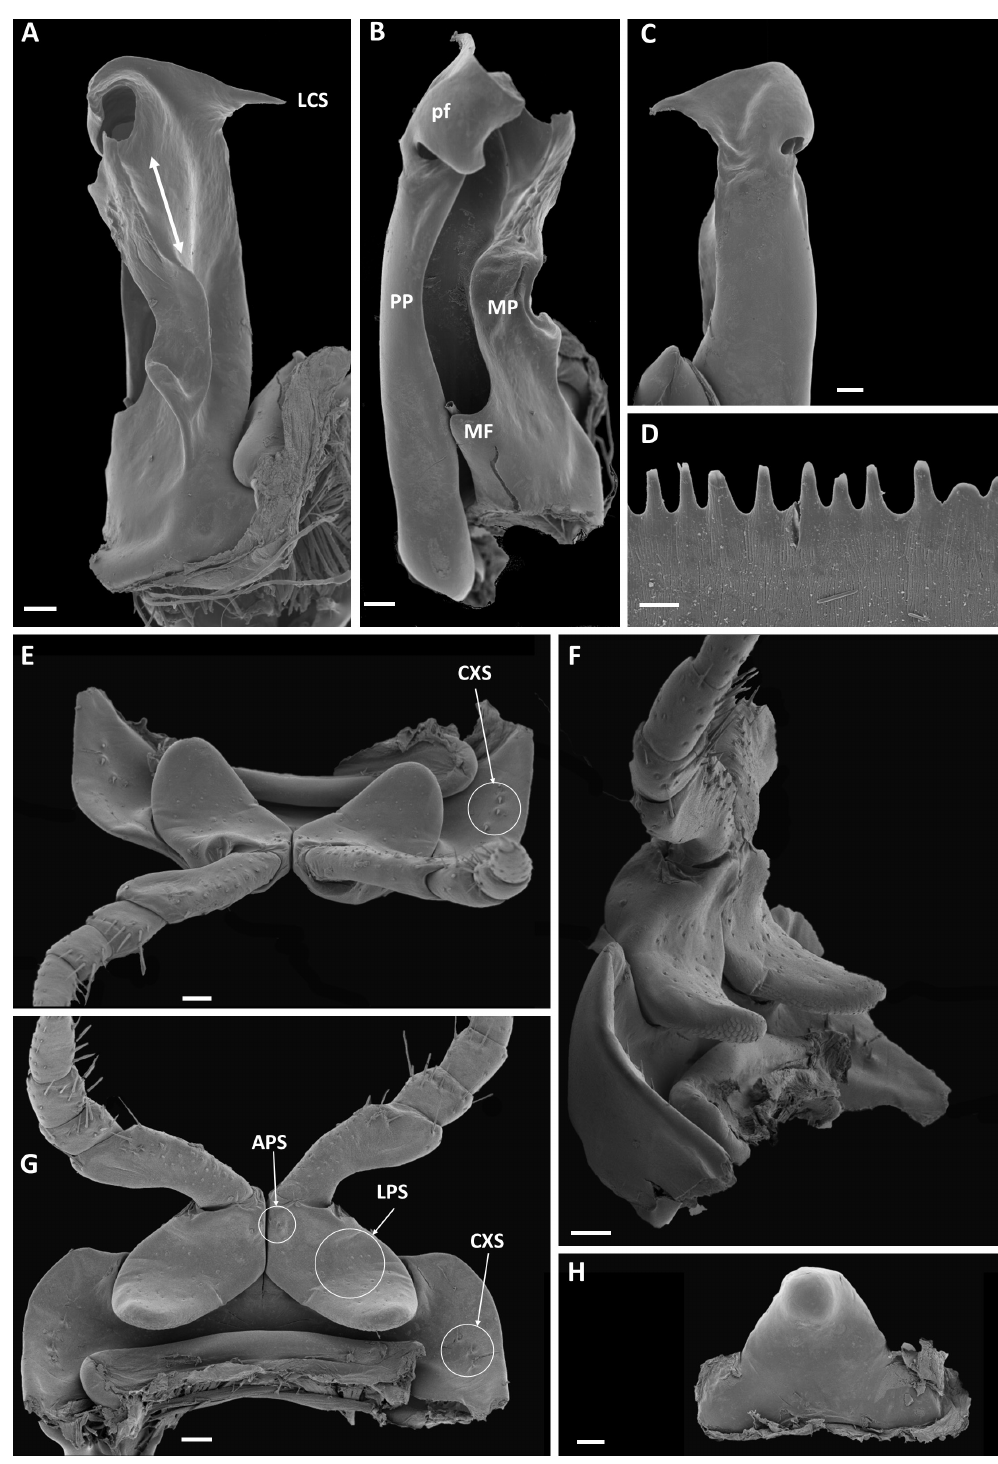
Fig. 60. Uncodrama coronata gen. et sp. nov., holotype, ♂ (NHMD 621765). A–C . Left gonopod coxa. A. Posterior view. B. Mesal view. C. Anterior view. D . Midbody dorsal limbus. E–G . First pair of legs. E. Ventral view. F. Sublateral view. G. Anterior view. H . Sternum 9. Abbreviations: APS = mesapical prefemoral sensilla; CXS = coxosternal setae; lcs = lateral coxal spine; LPS = lateral prefemoral sensilla; MF = metaplical flange; MP = metaplica; pf = proplical flange; PP = proplica; double-headed arrow: postero-lateral concavity. Scale bars: A–C, E–H = 0.1 mm; D = 0.01